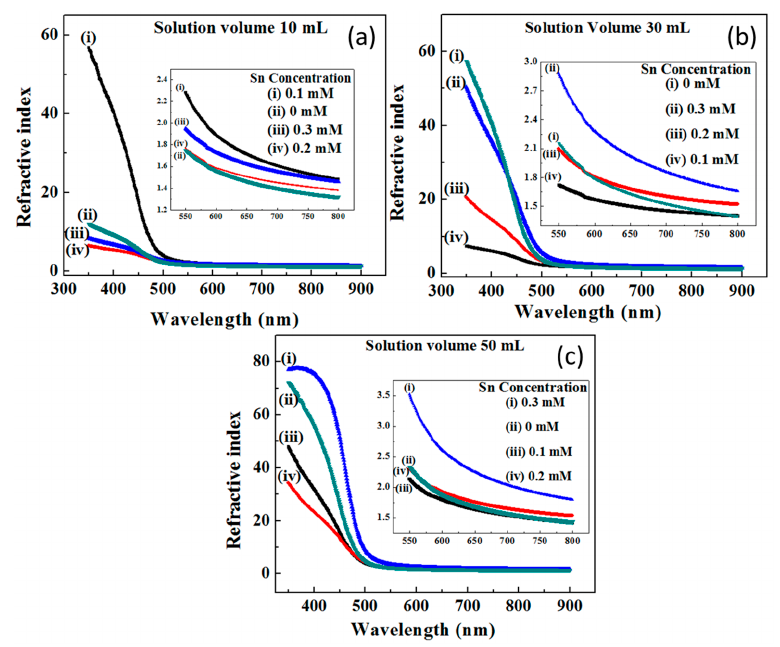
Figure 8. Refractive index of CdO films with different Sn concentrations and volumes. Insets are the magnified images for the same plots in the range of 550 nm to 800 nm.